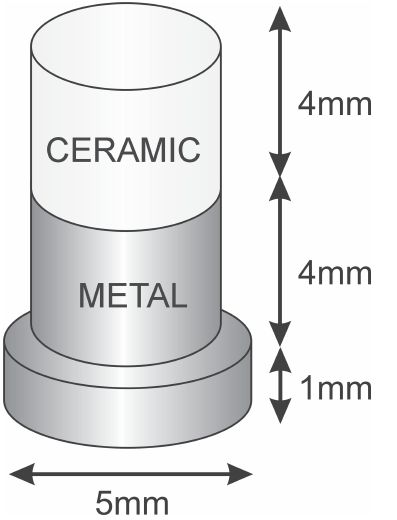
FIGURE 1- Specimen project and respective dimensions TABLE 2- Experimental groups division Group